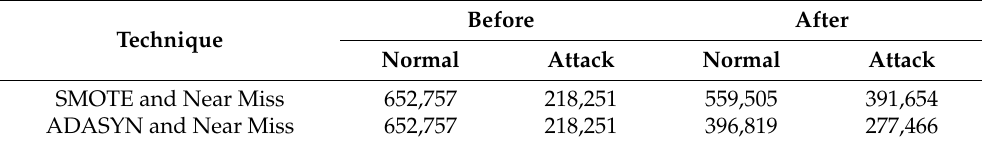
Table 13. Balancing the CICIDS2017 dataset with hybrid sampling.